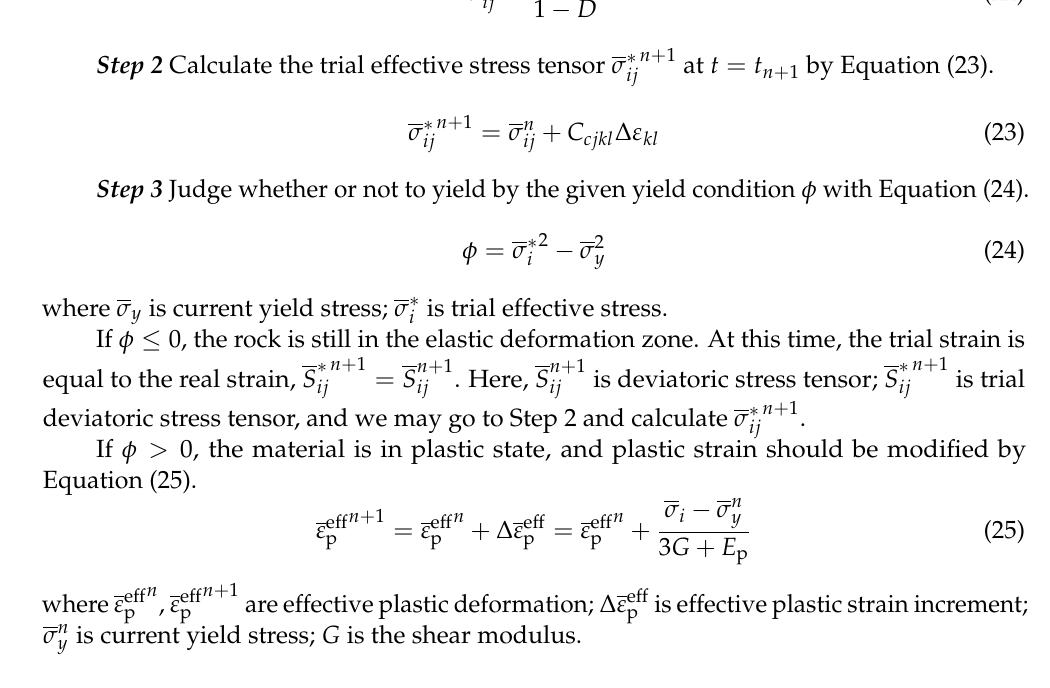
at t = t n by Equation ij